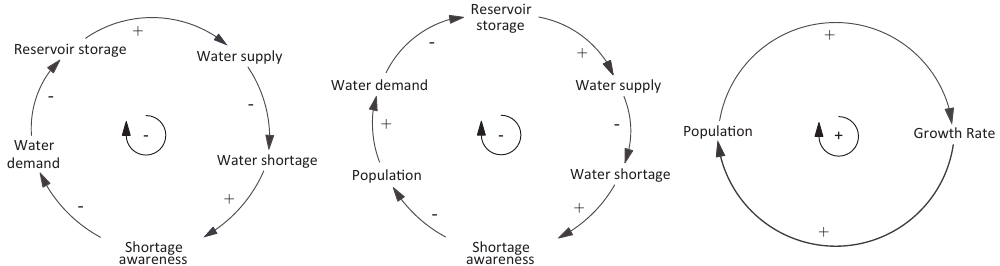
Figure 5. Causal loop diagrams: (a) water demand, shortage and conservation; (b) water demand, shortage and population; (c) population and growth rate. Table 4. State and exogenous model